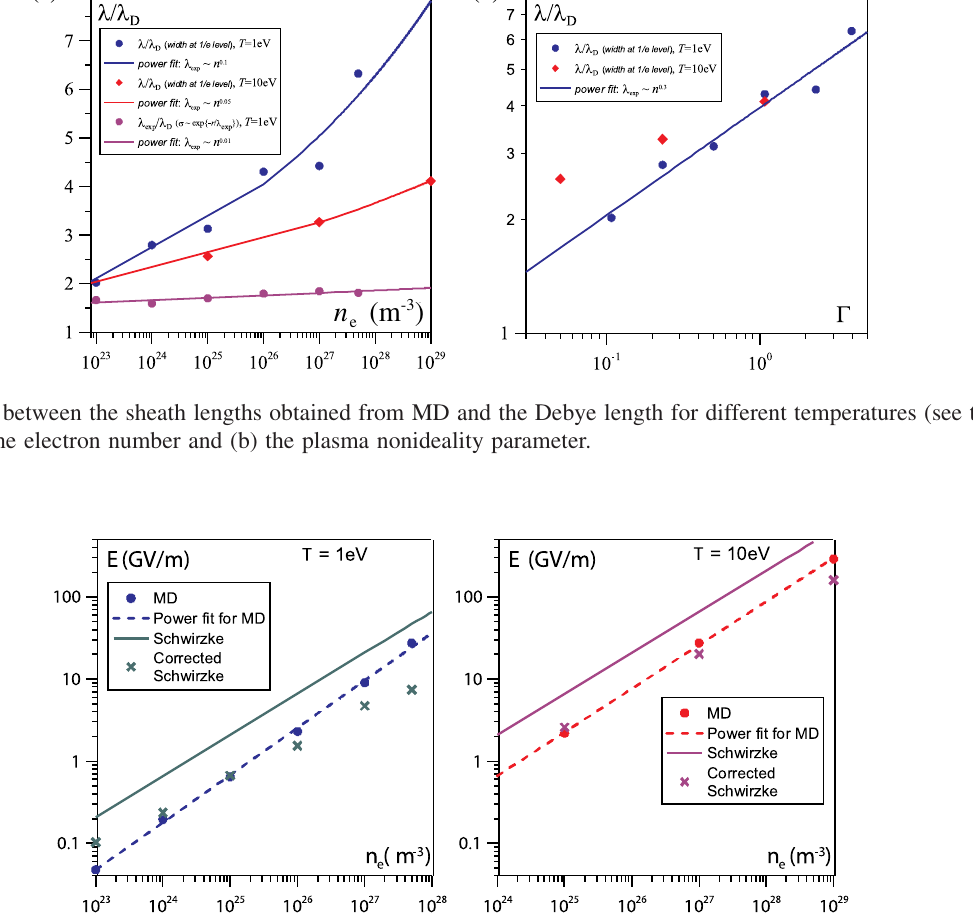
FIG. 10. Dependence of the final surface electric field strength on the electron number density for two values of temperature (shown on plots). MD results are compared with the theoretical estimations from [13]. Crosses correspond to Eq. (2) from [13] where the Debye length is replaced by the sheath lengths (cid:1) obtained from MD (Fig.